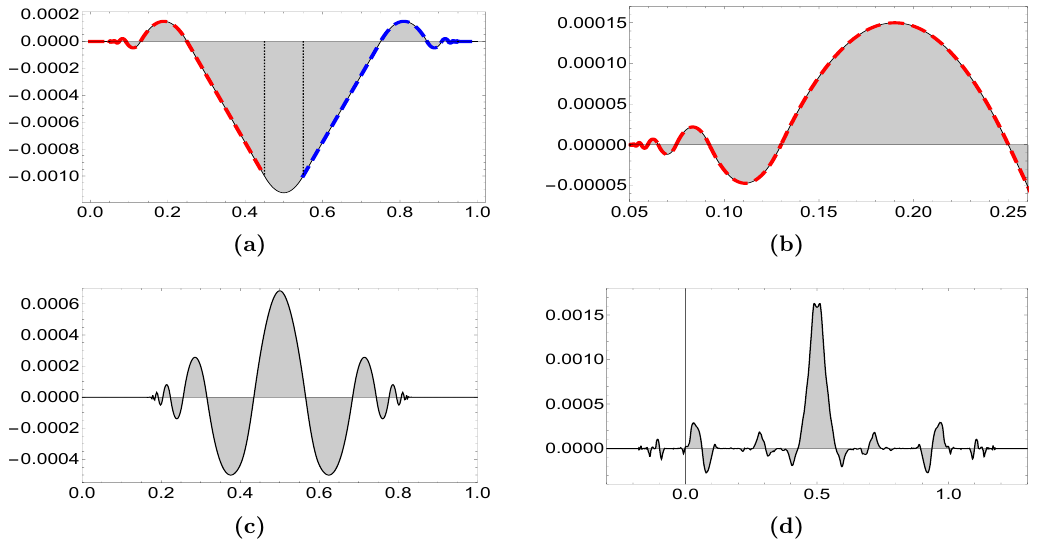
Figure 10. (a,b) Numerical solution (shadowed region under solid line) and self-similar exact components (dashed line) for (cid:15) = 0 : 1. (a,b) Field (cid:30) at t = 0 : 05, (c) (cid:12)eld (cid:30) at t = 0 : 17, (d) (cid:12)eld (cid:30) at t = 1 :